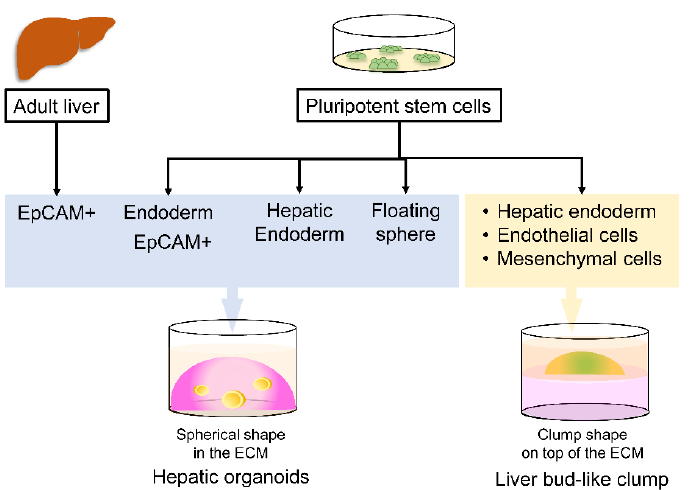
Figure 2. Source of liver/hepatic organoid-initiating cells. In the adult liver, EpCAM-expressing cells are capable of forming hollow, spherical shaped cells when embedded in a gel-like substance composed of the ECM and covered with liquid medium supplemented with essential growth factors and nutrients. Adult primary cell-derived hepatic organoids exert liver functions, including albumin synthesis, glycogen and lipid storage, and cytochrome P450 activity. As an alternative to the adult liver, human PSCs have been employed for the preparation of EpCAM+ endodermal, hepatic endodermal, endothelial and mesenchymal cells. As their counterparts in the adult liver, EpCAM+ endodermal cells and the hepatic endoderm formed hepatic organoids. In a 2D culture of hepatocytes derived from human PSCs, floating spheres appear over monolayers and are capa- ble of forming 3D hepatic organoids. The liver bud, a clumped shape lacking a hollow space, forms upon the plating a mixture of hepatic endodermal, endothelial and mesenchymal cells on Matrigel. To date, the PSC-derived liver bud is the most physiologically relevant structure to the adult liver in terms of its architecture and function. To generate organoids from pluripotent stem cells, it is necessary to follow the de- of germ layers, the endoderm gives rise to the hepatic endoderm, which then differentiates into hepatoblasts and functional hepatocytes. At present, stepwise protocols for the dif- ferentiation of hepatocytes from pluripotent stem cells involve establishment in a conven- tional 2D culture [30,61]. To form an organoid, a specific cell type is embedded in a gel- like ECM to allow cells to proliferate, differentiate and organize themselves in three di- mensions. Two approaches are utilized to generate hepatic organoids from PSCs depend- ing on the type of embedded cells. 6.2.1. Single Cell Type-Derived Hepatic Organoids In human fetal and neonatal livers, parenchymal cells expressing epithelial cell ad- hesion molecule (EpCAM) are capable of differentiating into hepatocytes and cholangio- cytes (biliary epithelial cells) [62]. Similar to the fetal liver, a human adult liver has ductal cells expressing EpCAM. When cultured in 3D, the isolated EpCAM+ cells were shown to generate liver organoids [63] (Figure 2). To recapitulate in vivo findings, EpCAM-express- ing endodermal cells were generated from human iPSCs and shown to self-organize into hepatic organoids in three dimensions [64]. By using this method, the hepatic organoids could be maintained in vitro for more than 16 months. An additional 10-14 days were required for the EpCAM-derived hepatic organoids to exhibit mature hepatocyte func- tions, including albumin synthesis, CYP3A4 activity, glycogen storage and low-density lipoprotein uptake [65]. While the long-term maintenance of EpCAM-derived hepatic or- ganoids is known, the length of time that mature hepatic organoids can be cultured in